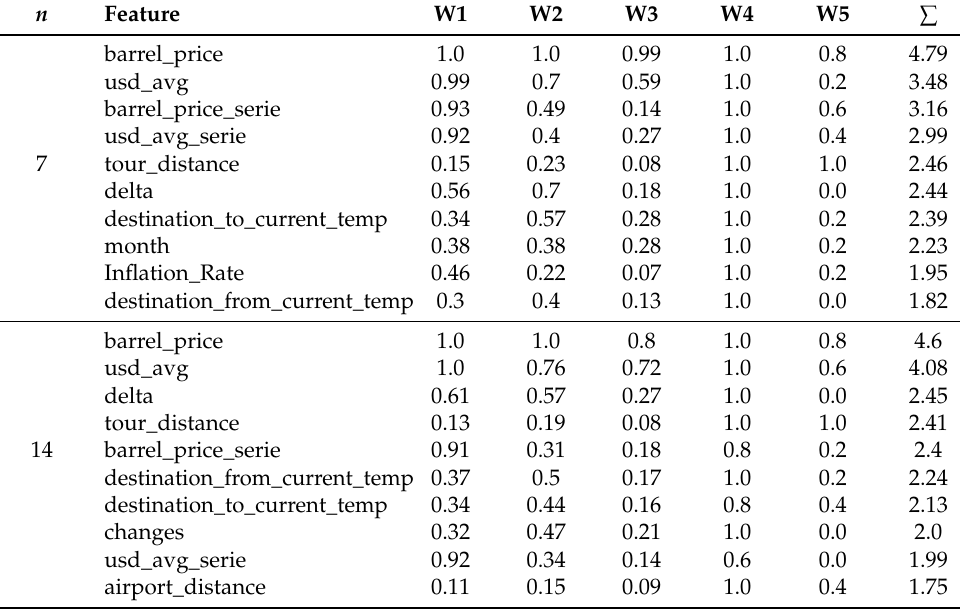
Table A2. Results obtained for top 10 features identified in each classification problem for trips with flight